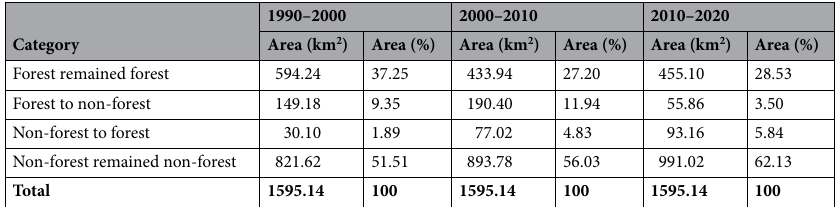
Table 4. Transition in forest cover (1990 to